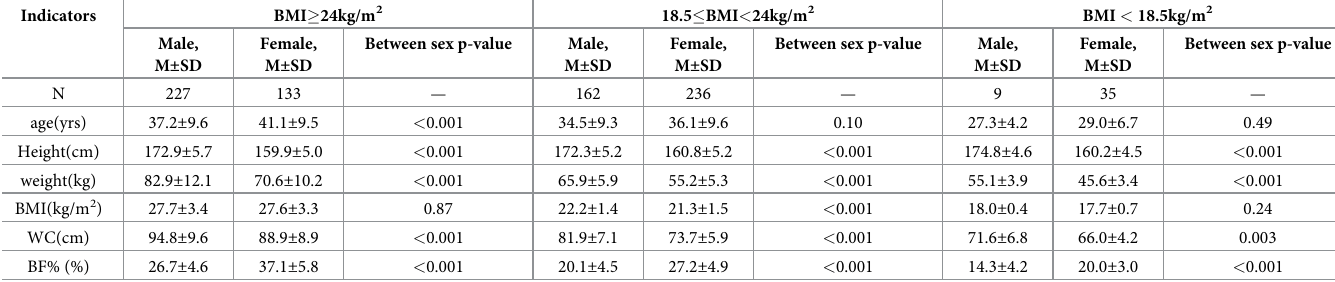
Table 1. Baseline characteristics of 802 subjects stratified different BMIs. Walking intervention clinical trial in China, 2015–2016.